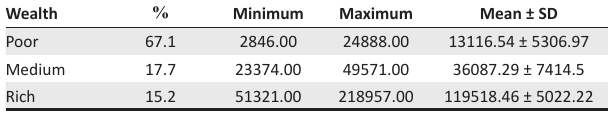
TABLE 3: Income of households by